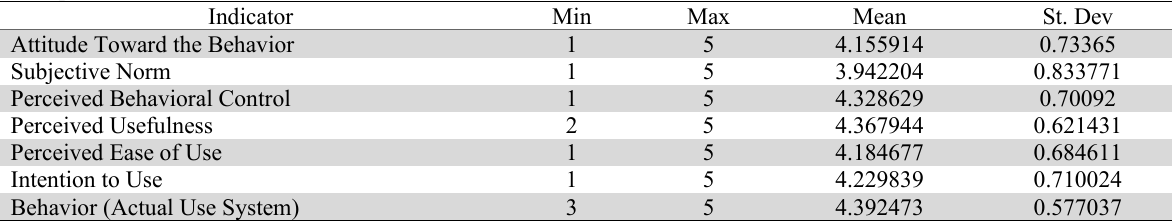
Descriptive Variable Results